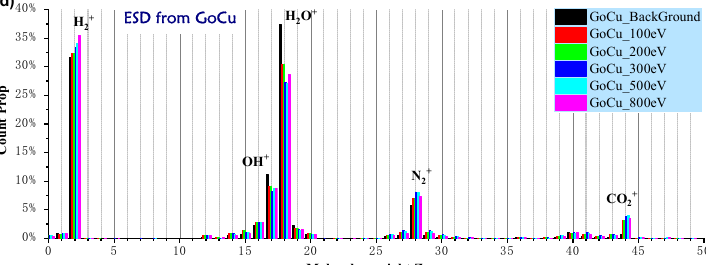
Figure 9. ESD gas components of graphene on Cu and Cu under different irradiation energy: ( a , c ) ESD from Cu, ( b , d ) ESD from GoCu.